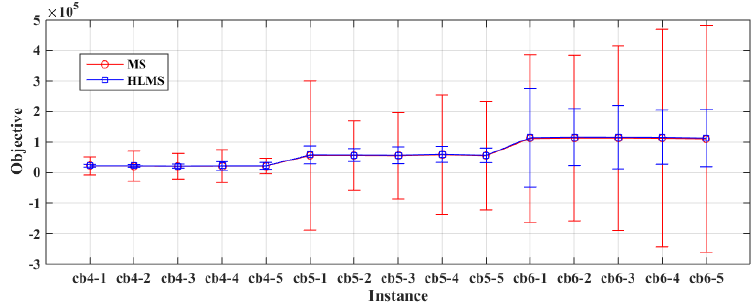
Figure 8. Error bars (Variance) for MS and HLMS on Test set III (cb4–cb6).